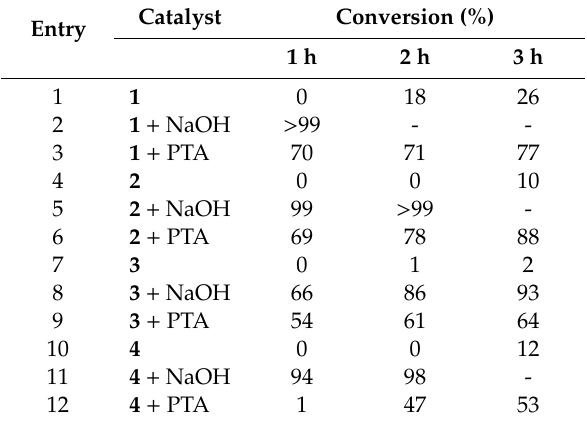
Table 6. Hydration of benzonitrile with [RhCl(cod)(NHC)] catalyst 1 – 4 . Entry